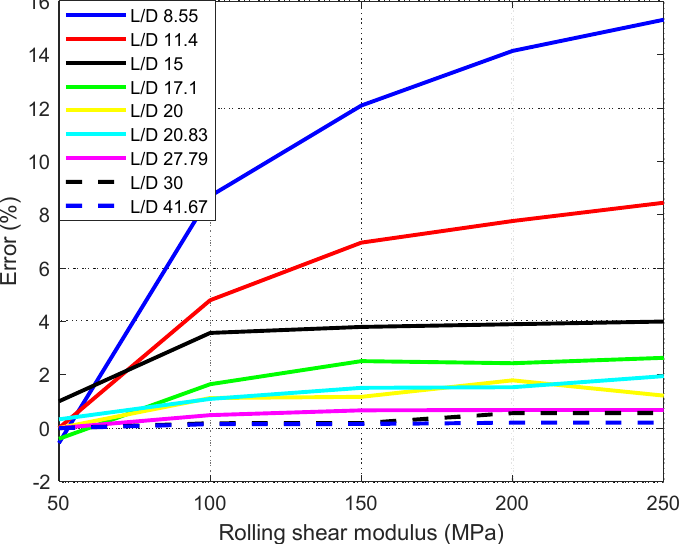
Figure 6. Deviations in deflection predictions obtained using FE models vs. analytical methods.